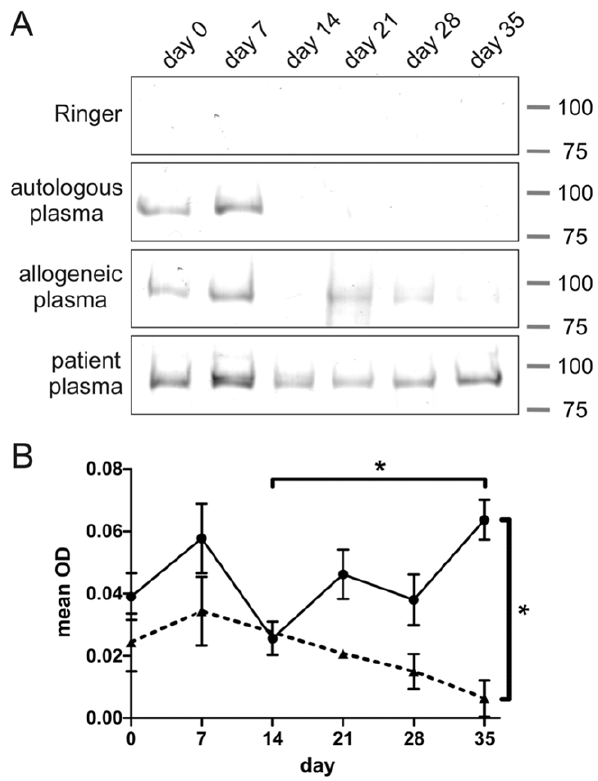
Figure 1. Erythrocyte autoantibody immunoprecipitation of erythrocytes sampled at regular time intervals during storage. Analysis was performed by SDS-PAGE, followed by silver staining. (A) Protein patterns of precipitates obtained using Ringer, autologous plasma, and a representative example from one out of three allogeneic plasmas, and one out of six autoantibody-containing plasmas (patient N No. 2). For the allogeneic controls, day 14 is missing. (B) Mean optical , solid line, N=6 patients) and allogeneic density (OD) of patient ( control plasma ( m , dotted line, N=3 volunteers) precipitations. Numbers indicate approximate molecular weight (kDa). Error bars represent standard error, * p , 0.05.